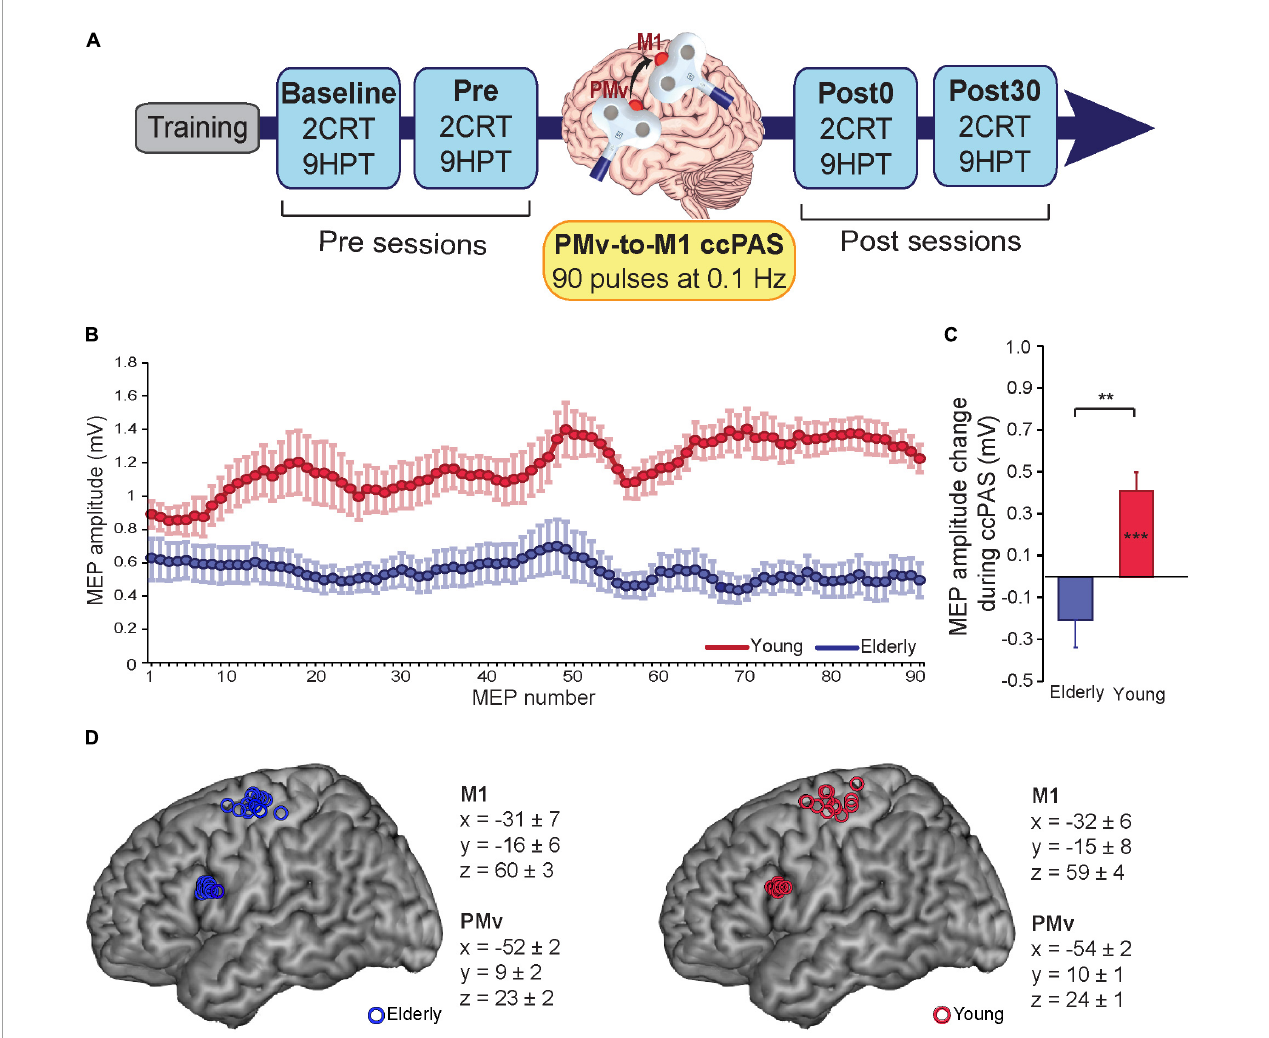
FIGURE1 (A) Experimental design. (B) motor-evoked potentials (MEPs) during cortico-cortical paired associative stimulation (ccPAS) in elderly adults (blue) and young adults (red). (C) MEP modulation index in the two groups (the last 10 MEPs relative to the first 10 MEPs acquired during ccPAS). (D)